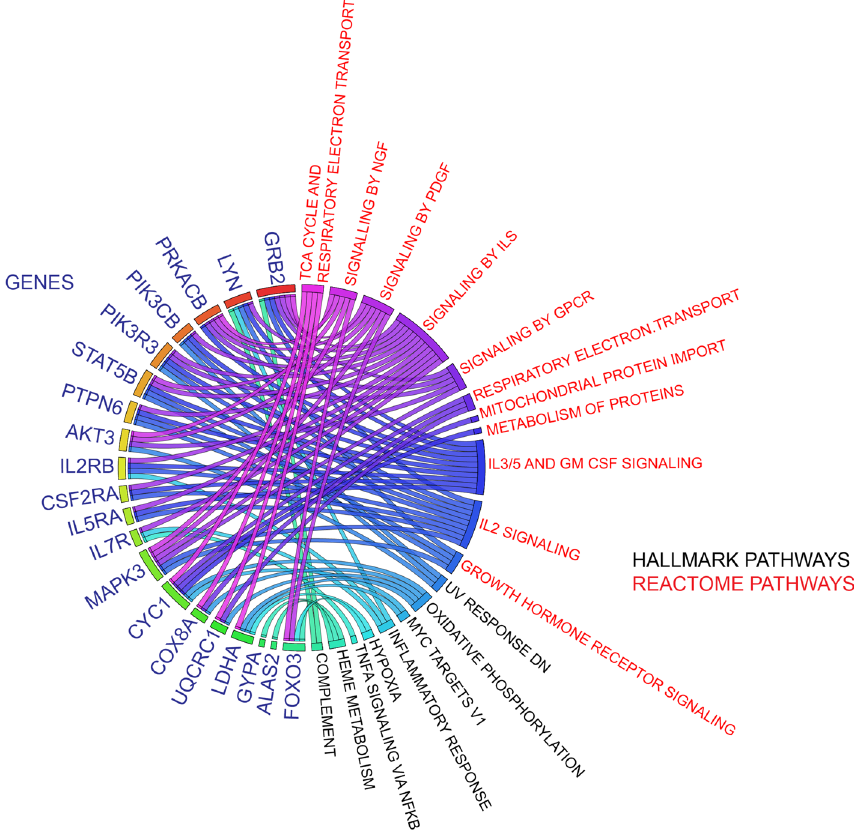
Figure 4. Circos plot linking the validation target genes to their associated pathways of interest. (Circos software version 0.69 and Circos Table Viewer software version 0.63, http://www.circo s.ca/softw